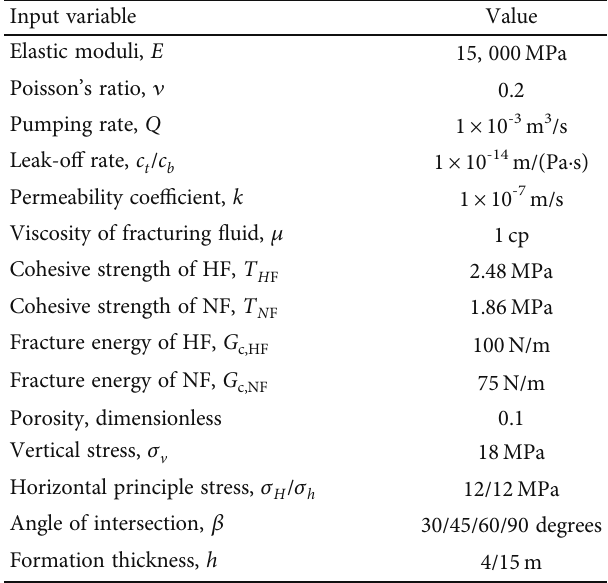
and the overburden stress σ is along the height of this domain. The H v Table 3: Input variable values of the fi nite element numerical calculation of 3D simple hydraulic and natural fracture